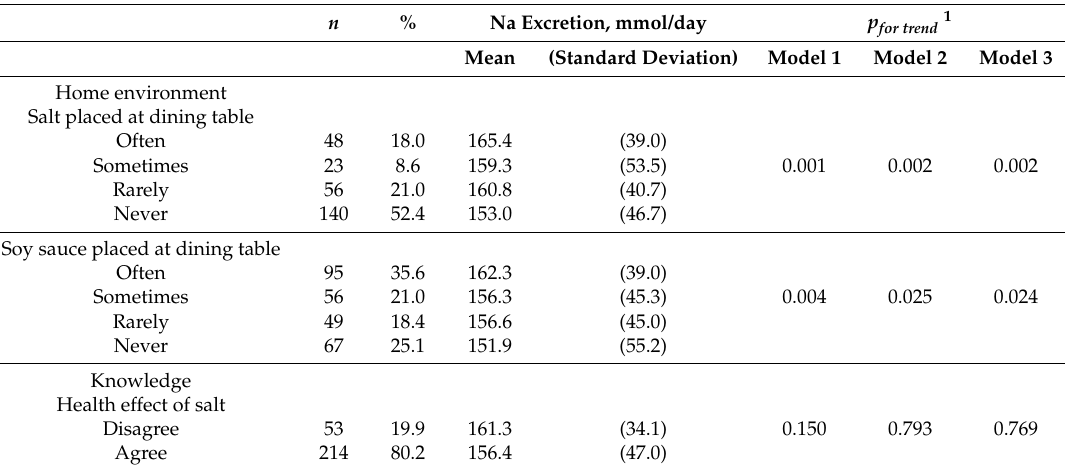
Table 3. Estimated Na excretion and related factors ( n =